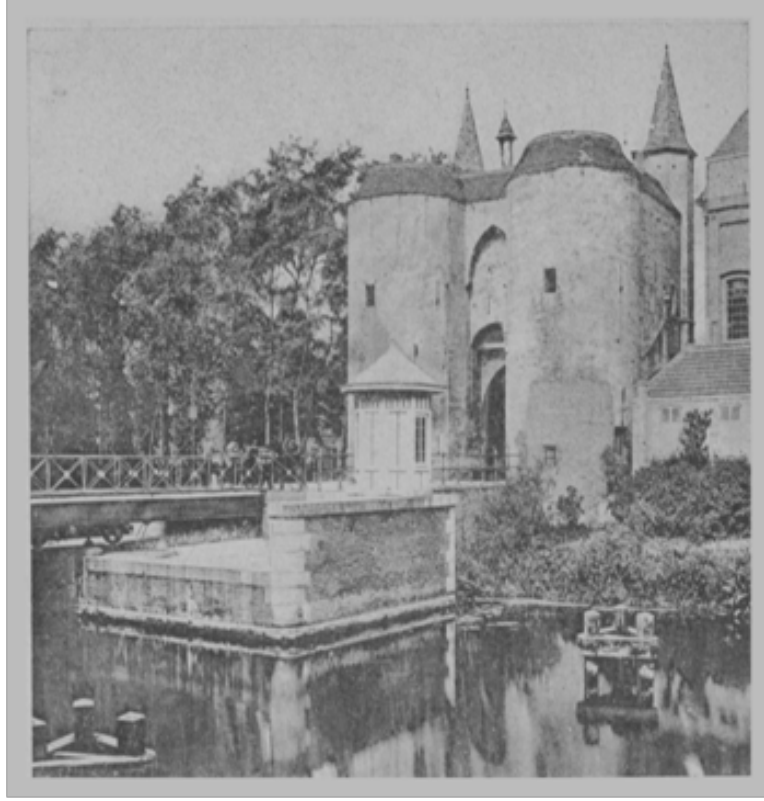
Figure 9. Anonymous. Photograph of Gentpoort in Bruges La Morte